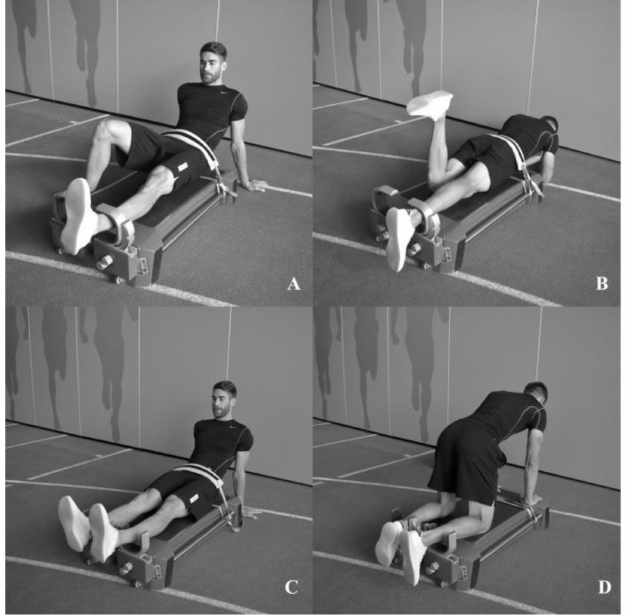
Figure 1. Position of subjects during isometric hip strength testing. ( A ) flexion; ( B ) extension; ( C ) abduction / adduction; and ( D ) internal / external